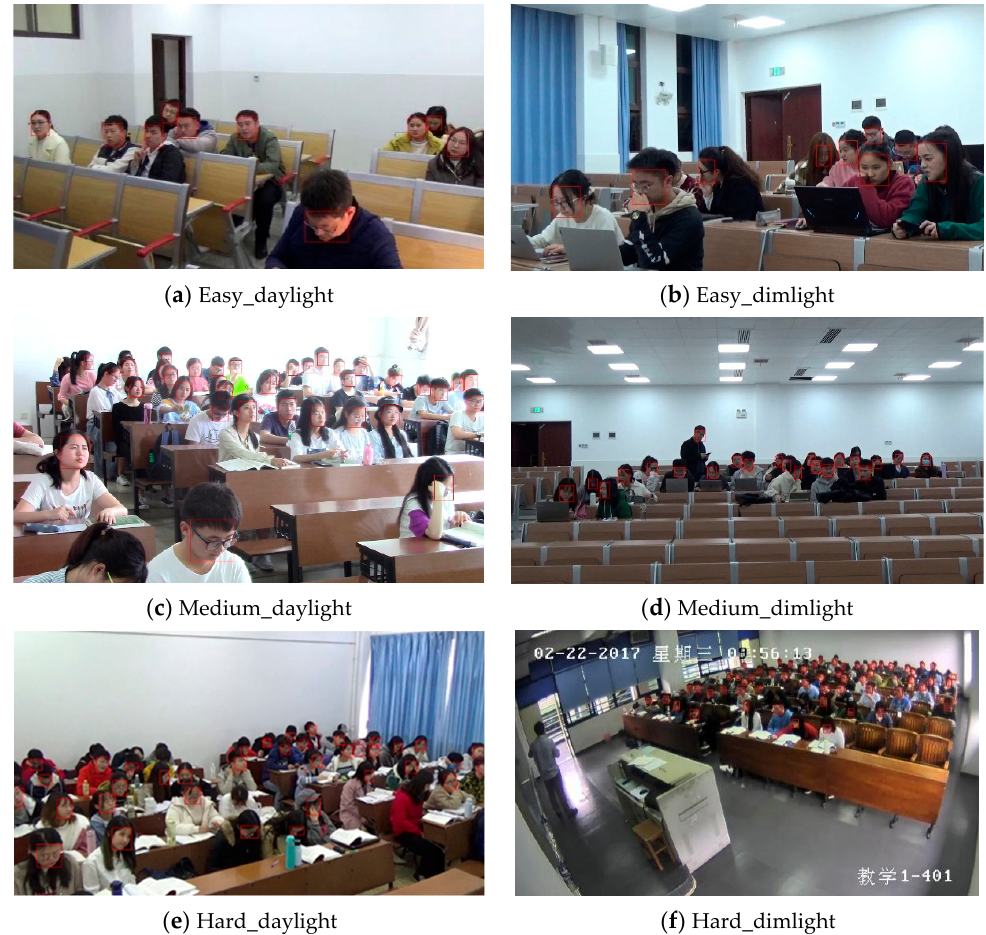
dents’ faces are consistent.